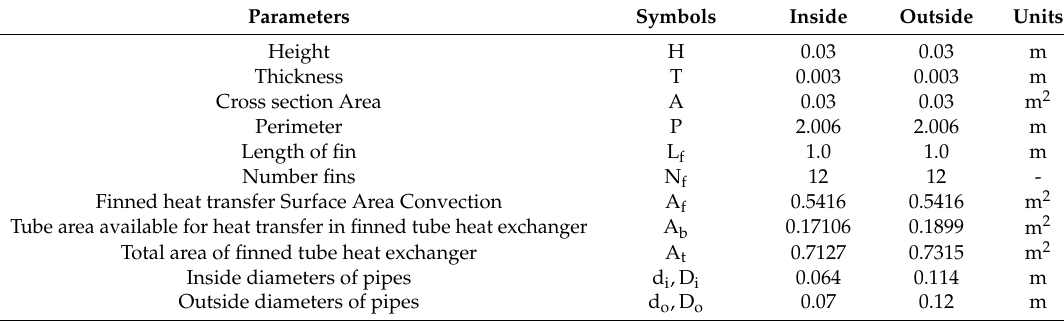
Table 6. Dimensions of heat exchanger.